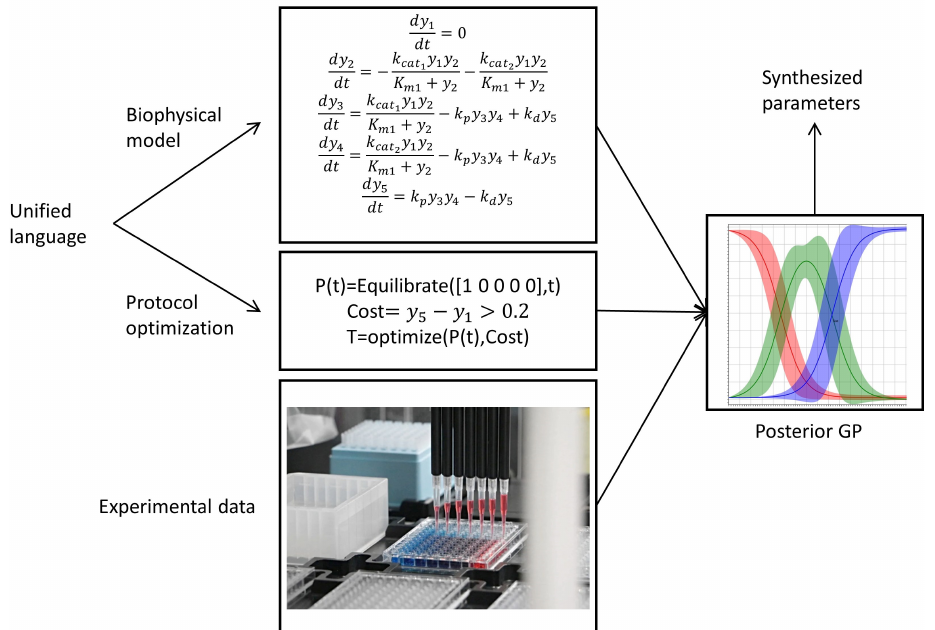
Figure 1. Processing a unified description for an experimental protocol. A program integrates a biophysical model of the underlying molecular system with the steps of the protocol. In this case, the protocol comprises a single instruction, which lets a sample equilibrate for t seconds, where t is a parameter. The initial concentration of the sample is 1 for the first species and 0 for all the others. The value of t is selected as the one the maximizes a cost function, in this case the difference between y 5 and y 1 after the execution of the protocol. The optimization is performed on a Gaussian process given by the semantics of the program (biophysical model and protocol) integrated with experimental